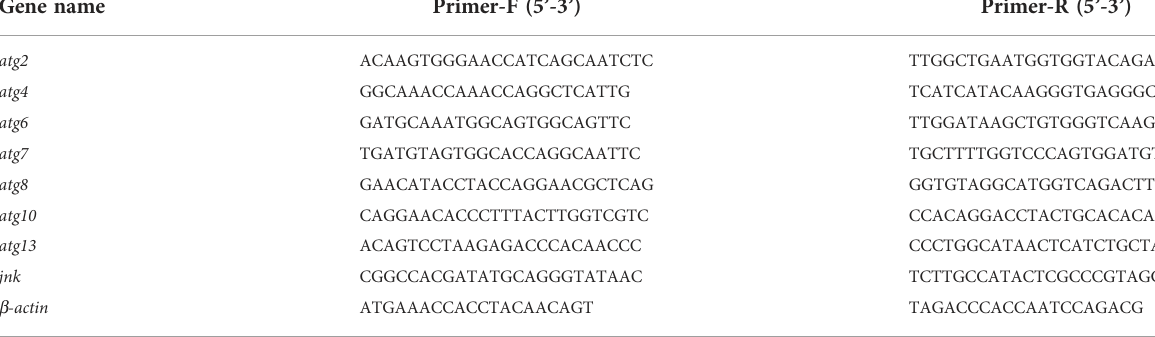
TABLE 1 Primer table for qRT-PCR detection of autophagy